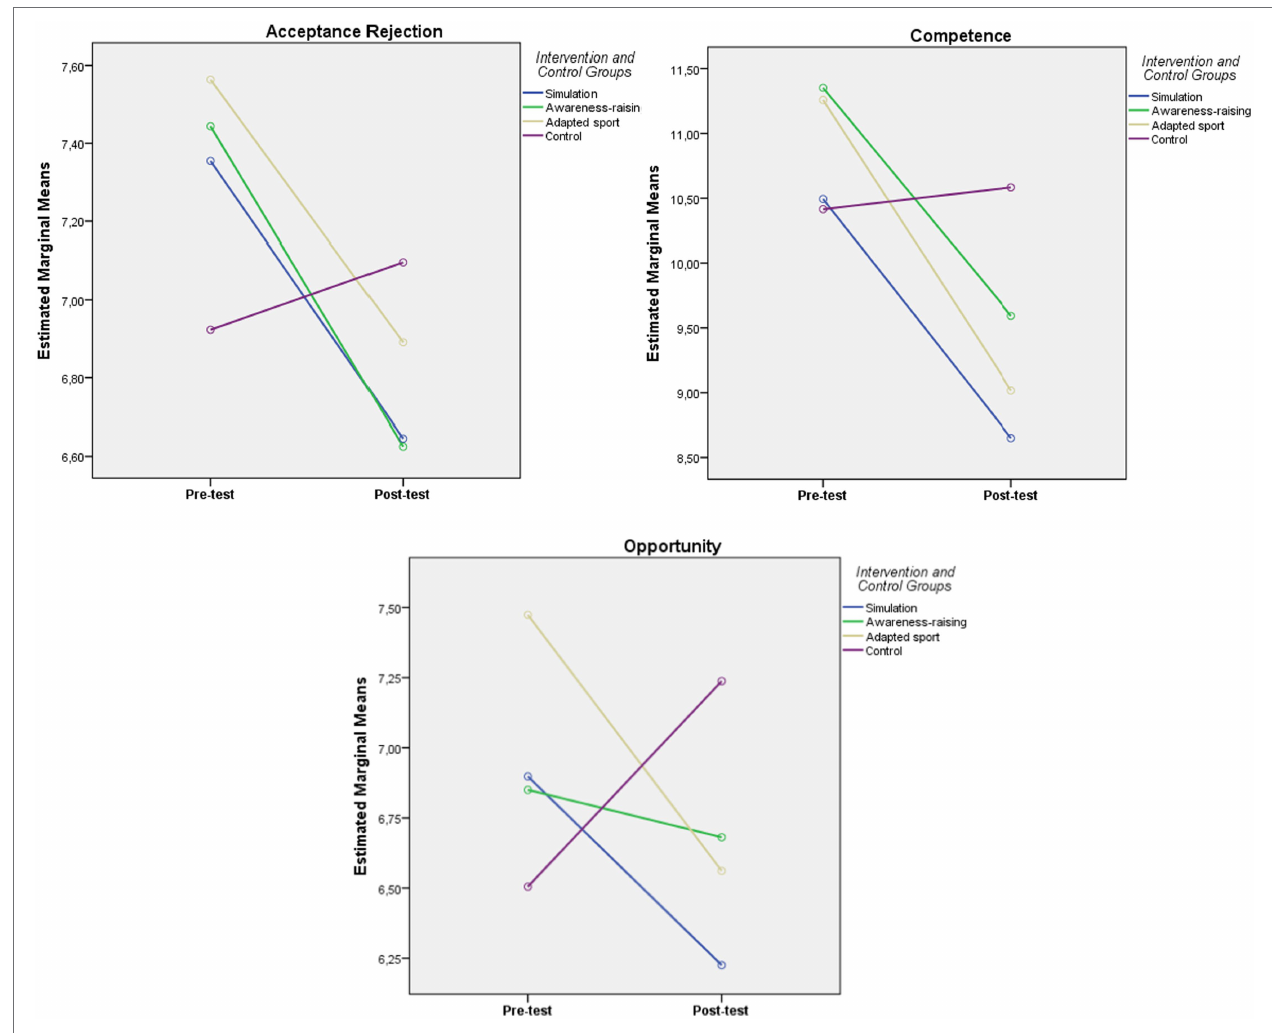
FIGURE 1 | Results graphically Student t -test for related